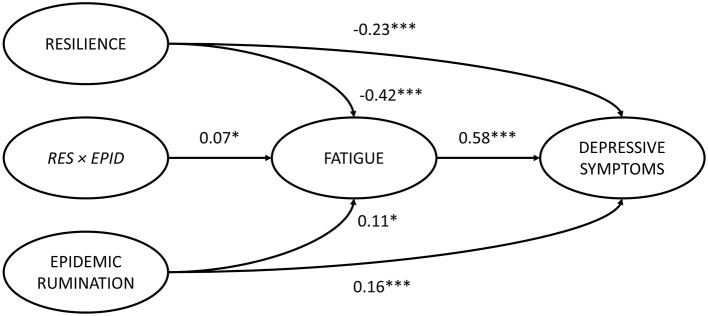
Path model of the proposed conceptual model. ***p < 0.001, **p < 0.01, *p < 0.05.